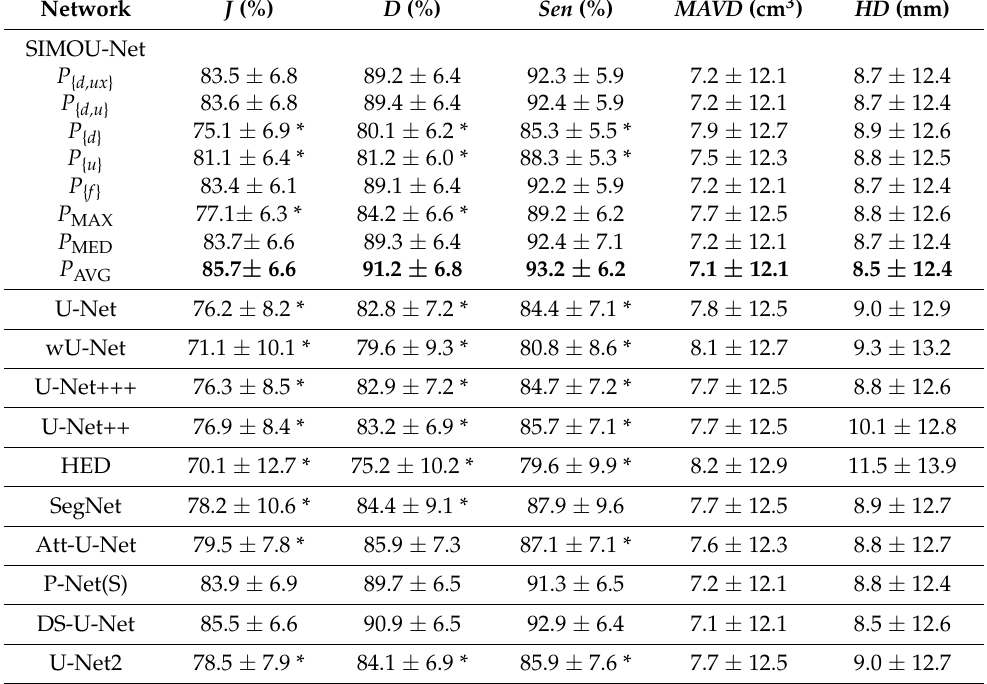
Table 2. Average quantitative results (mean ± standard deviation) trained and validated on 200 normal cases and tested on 54 abnormal cases. Bold typeface indicates the best performing method for each metric. * indicates a significant difference with respect to the P AVG score after performing a Nemenyi